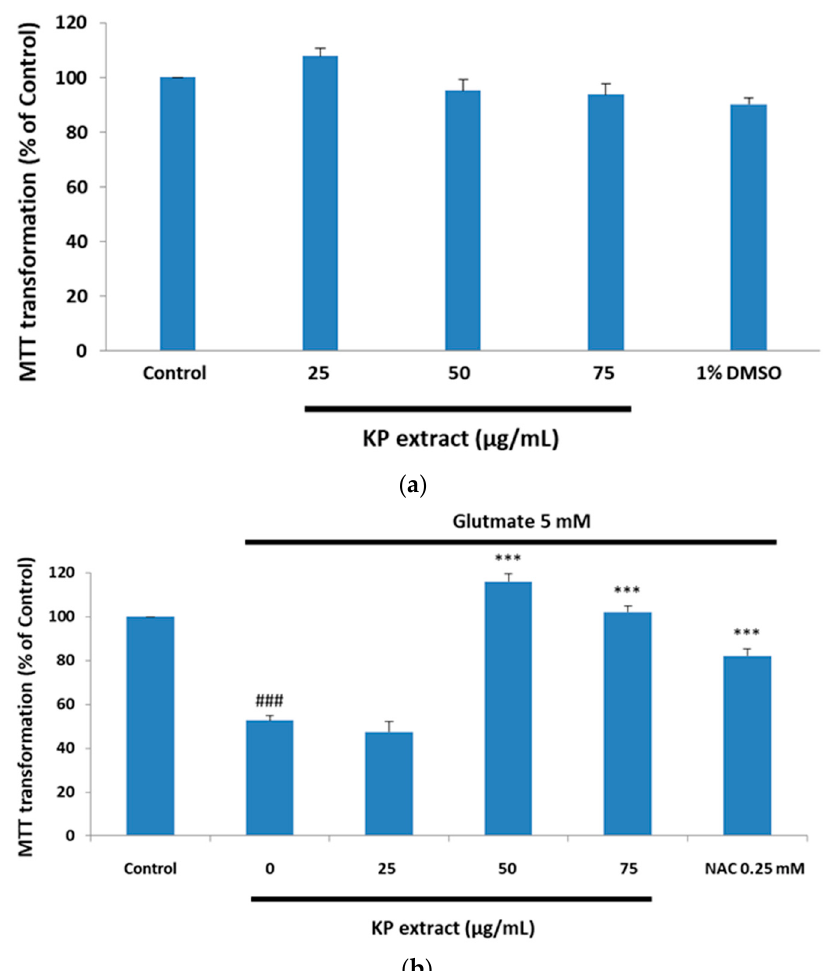
Figure 1. Neuroprotective effect of Kaempferia parviflora Wall. ex Baker (KP) extract on glutamate- induced cytotoxicity in HT-22 cells. ( a ) Cells were treated with various concentrations of KP extract (25, 50, and 75 µ g/mL) for 14 h; ( b ) cells were exposed to 5 mM of glutamate alone or glutamate in combination with different concentrations of KP extract for 14 h. Cell viability was determined by 3-(4,5-dimethylthiazol-2-yl)- 2,5-diphenyl tetrazolium bromide (MTT) assay. Each bar represents the mean ± SEM from 3 independent experiments per group. ### p < 0.001 vs. control and *** p < 0.001 vs. the glutamate alone.